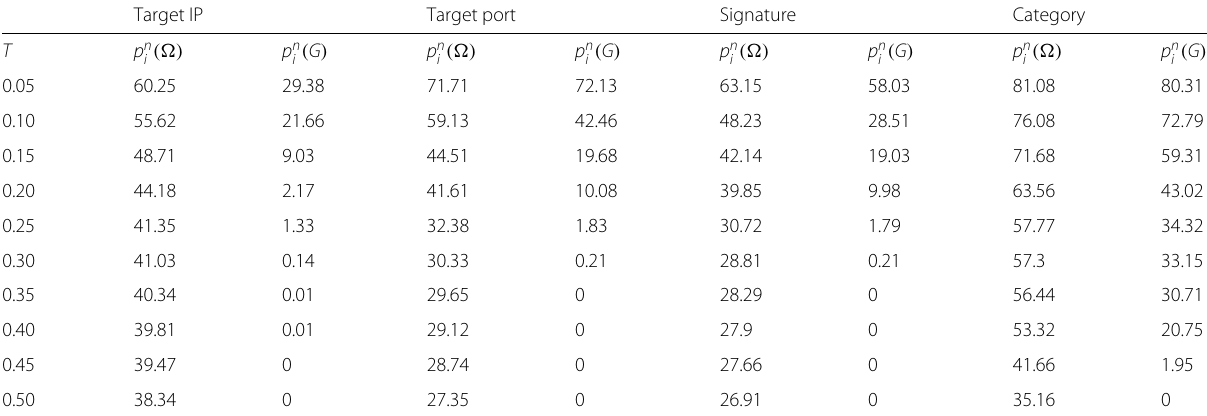
((cid:2)) > T and p n ( G ) > T for different features i i